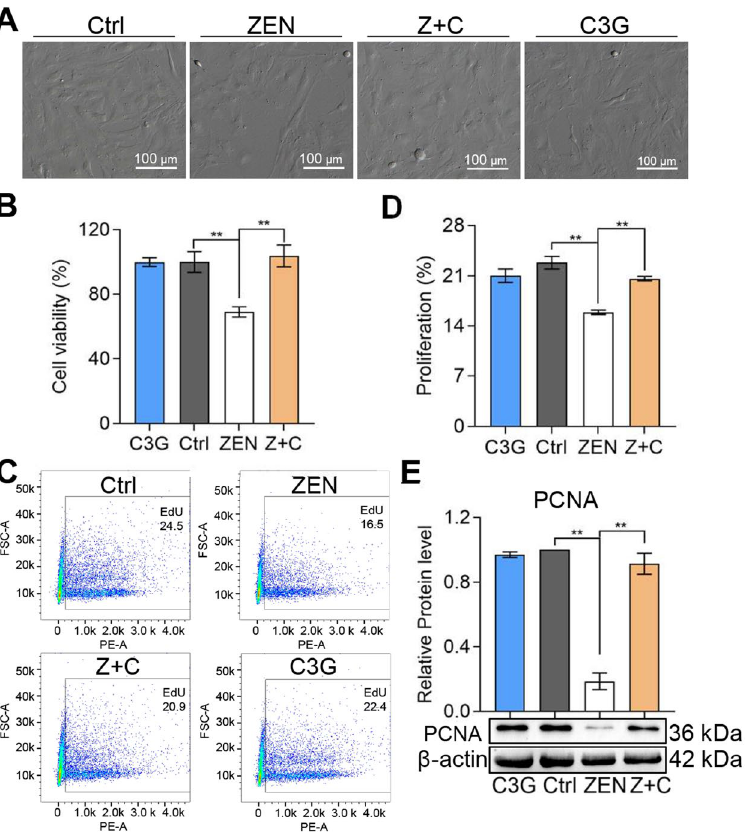
Figure 1. Effects of ZEN and C3G on proliferation. ( A ) Bright field imaging of pGCs between Ctrl, ZEN, Z+C, and C3G groups in vitro; scale bar = 100 µm. ( B ) Representative results of cell viability detected by CCK-8 determined from images similar to those in ( A ). ( C ) The proliferation rates were detected by flow cytometry using EdU staining. ( D ) Representative results of cell proliferation rates determined from flow cytometry in ( C ). ( E ) Representative results of relative protein levels of PCNA detected by WB and β -actin were used to reference proteins. All data were quantified as mean ± SEM; n = 3. All experiments were repeated at least 3 times. ** p < 0.01.